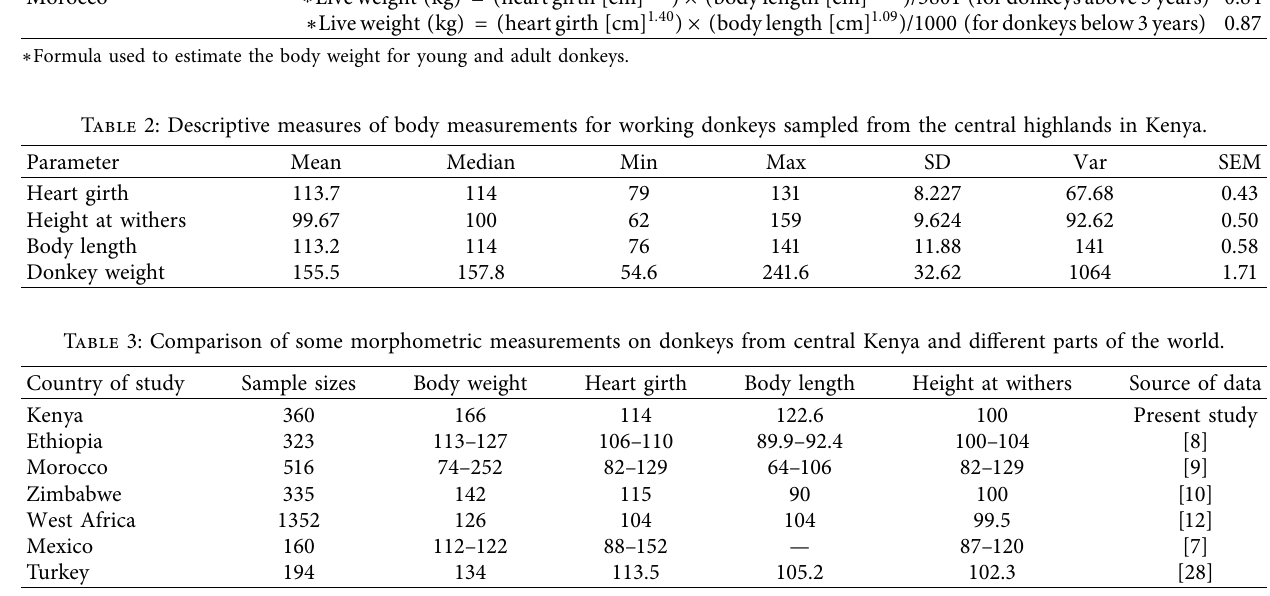
Table 4: Inferential analysis for weight, heart girth, body length, and height at withers for working donkeys classified by sex. Parameter description Body weight (kg) Heart girth (cm) Height at withers (cm) Table 5: Inferential analysis for weight, heart girth, body length, and height at withers for working donkeys classified by age group. Parameter description Body weight (kg) Heart girth (cm) Body length (cm) Height at withers (cm)